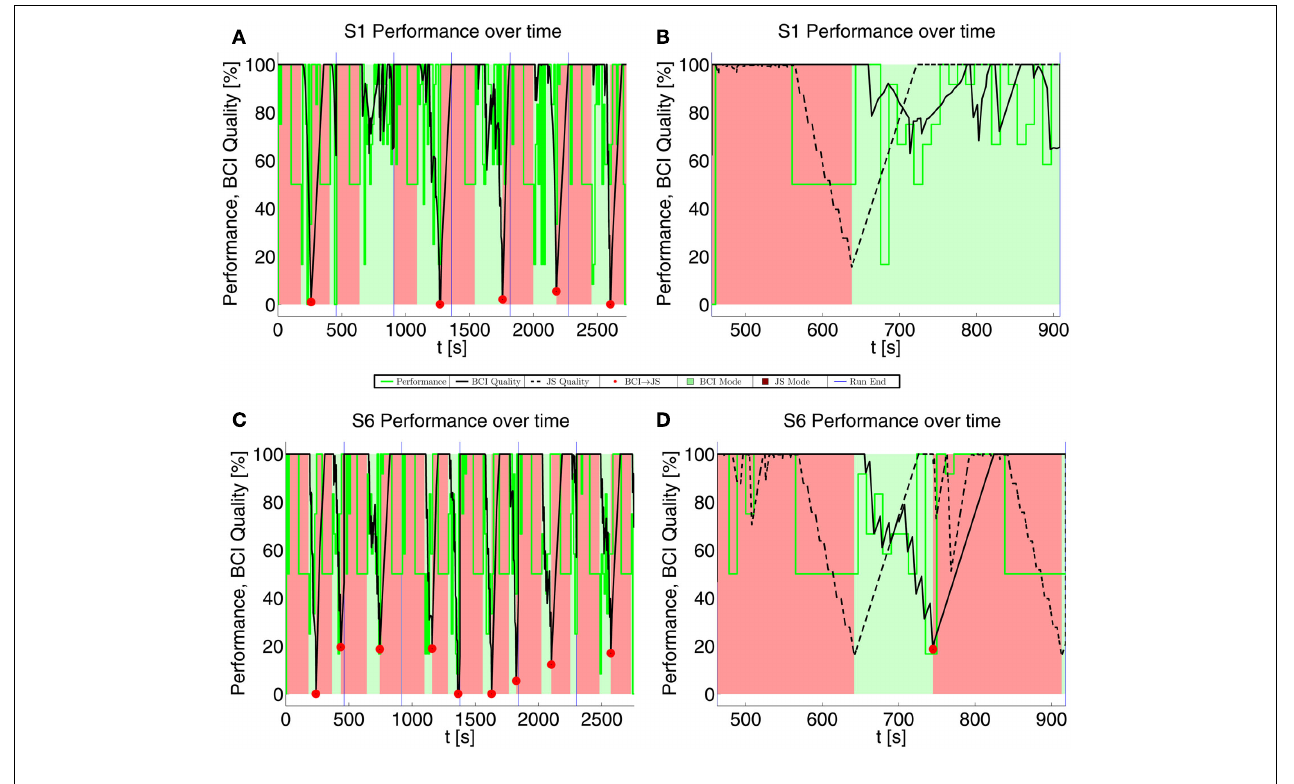
up coins and barriers, whereas the quality decreases and increases due to active quality measures and recovery rates, respectively.The start of a new run is indicated with blue vertical lines. A new run always started in JS mode, no matter in which mode the foregoing run concluded.